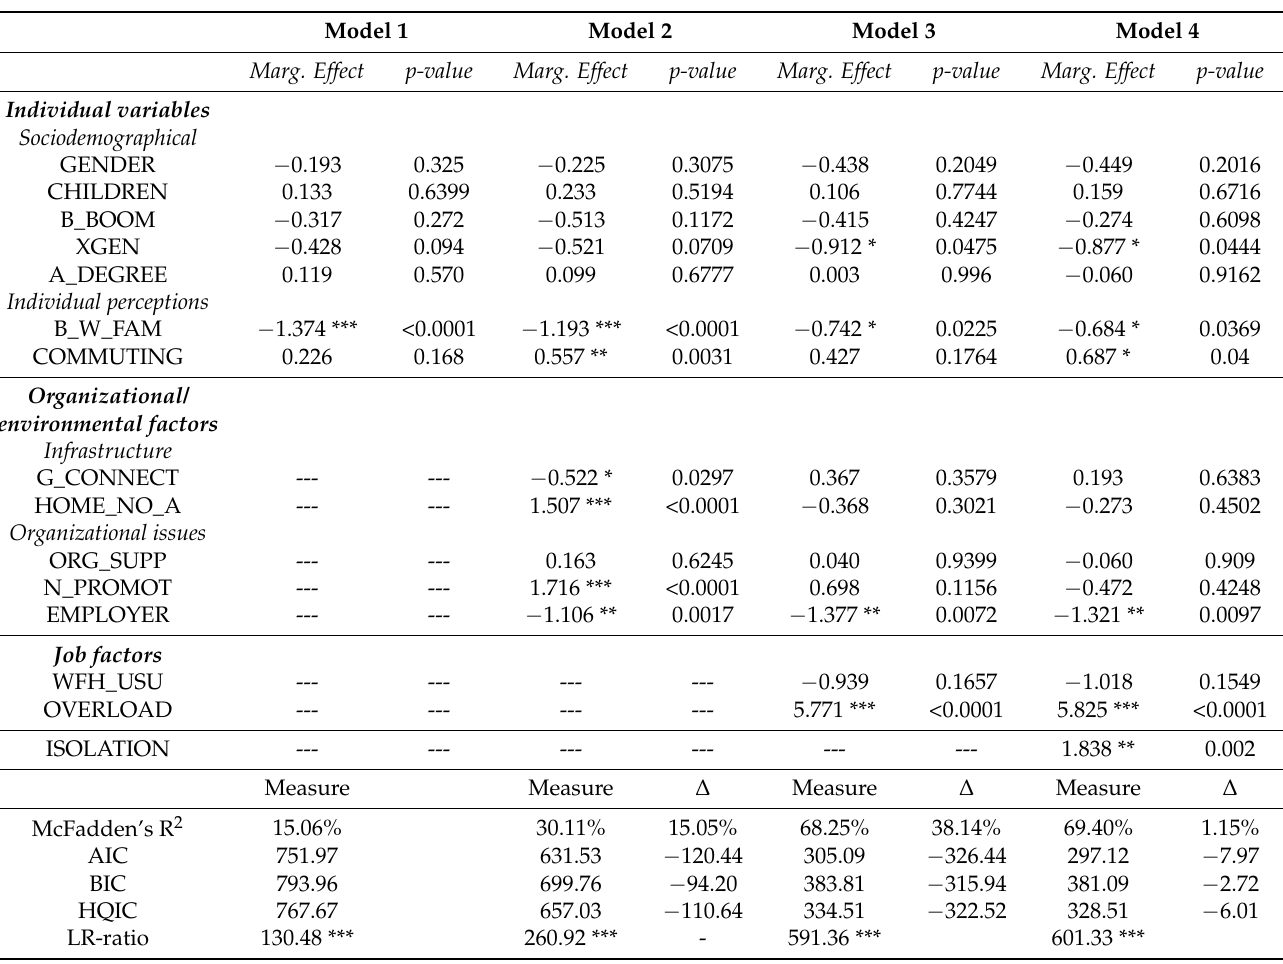
Table 3. Hierarchical logit regressions for